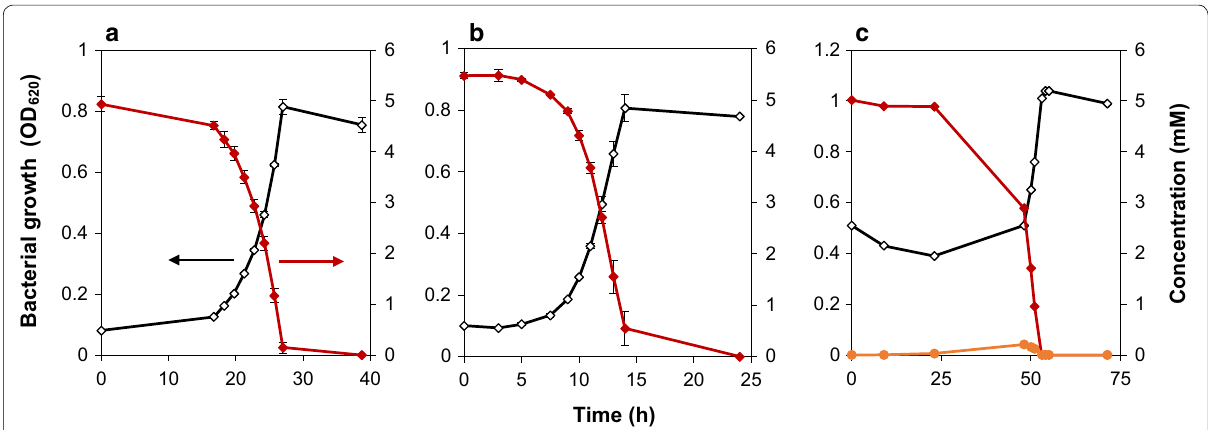
Fig. 3 Growth of Pseudomonas sp. isolate 9.1 on a vanillate, b 4‑HBA and c vanillyl alcohol as the only source of carbon. Experiments were performed in duplicates and the standard deviations are displayed with an error bar. One representative curve is shown for the growth and consumption on vanillyl alcohol. The OD and model compounds concentration (mM) are shown in black open diamond and red closed diamond respectively. The excreted intermediate vanillin is shown in orange closed circle (Read from right axis)